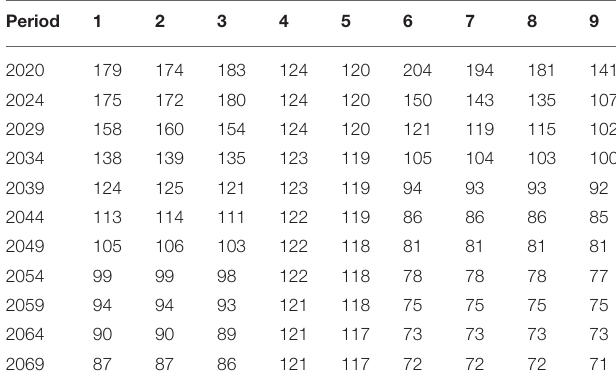
TABLE 4 | Projected net returns ($ ha − 1 ) across nine field-level scenarios for a representative farm in Hale County, Texas.